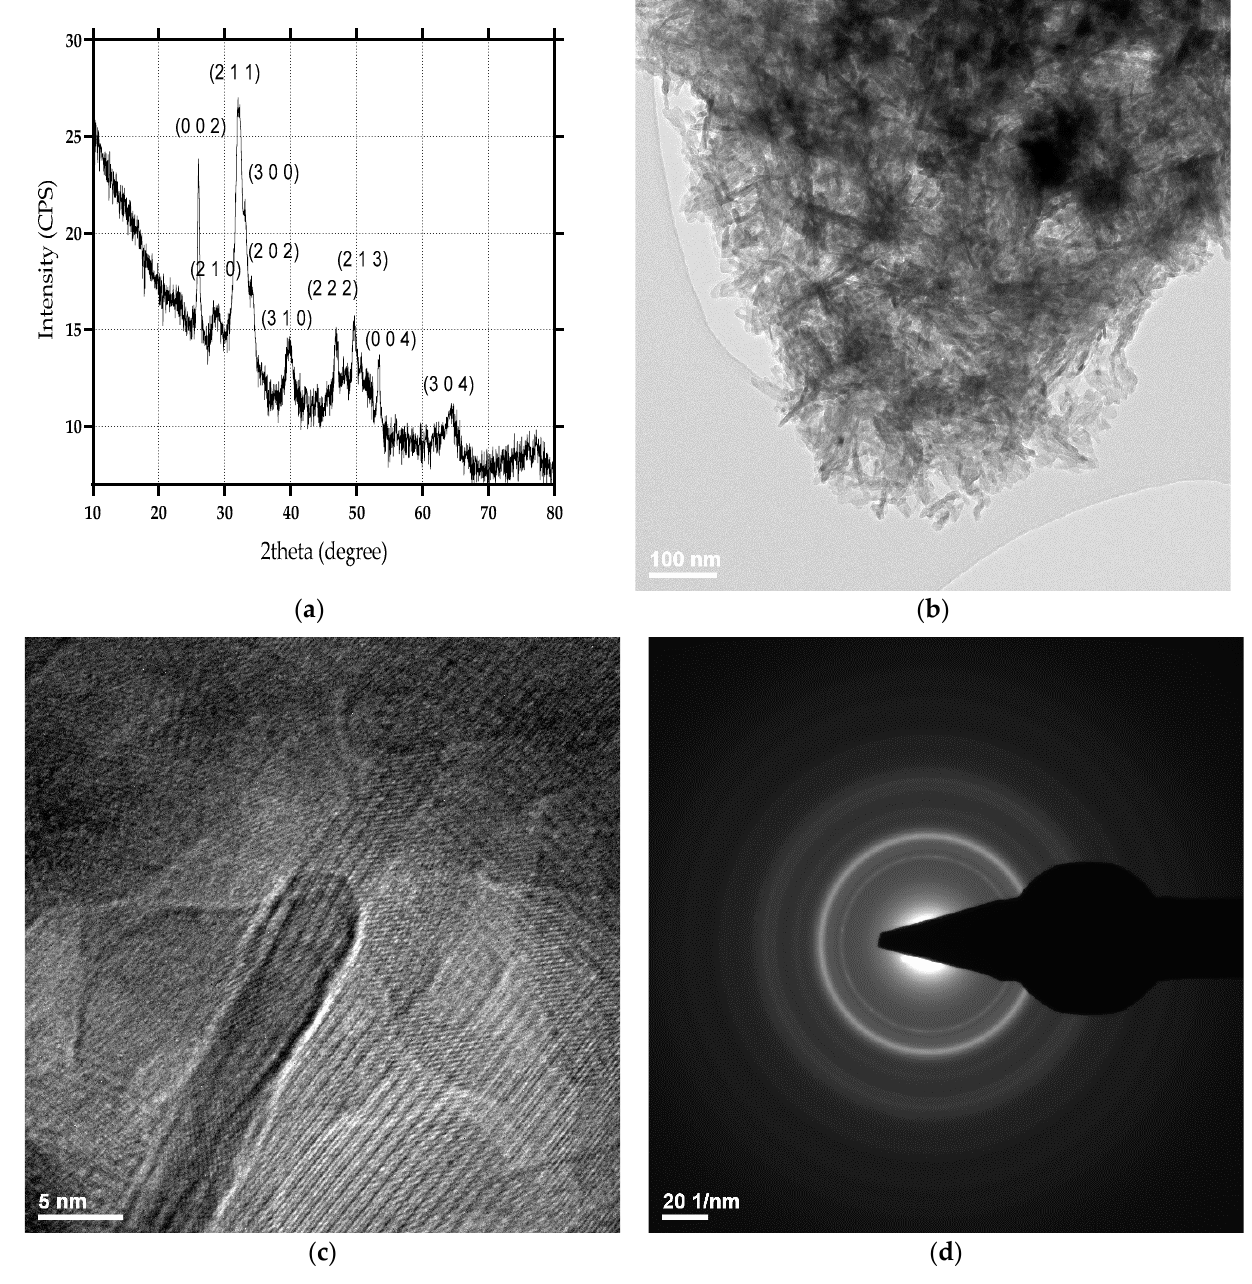
Figure 1. X-ray diffractogram ( a ), TEM image ( b ), HR-TEM image ( c ), and SAED pattern ( d ) for HA nanopowder.